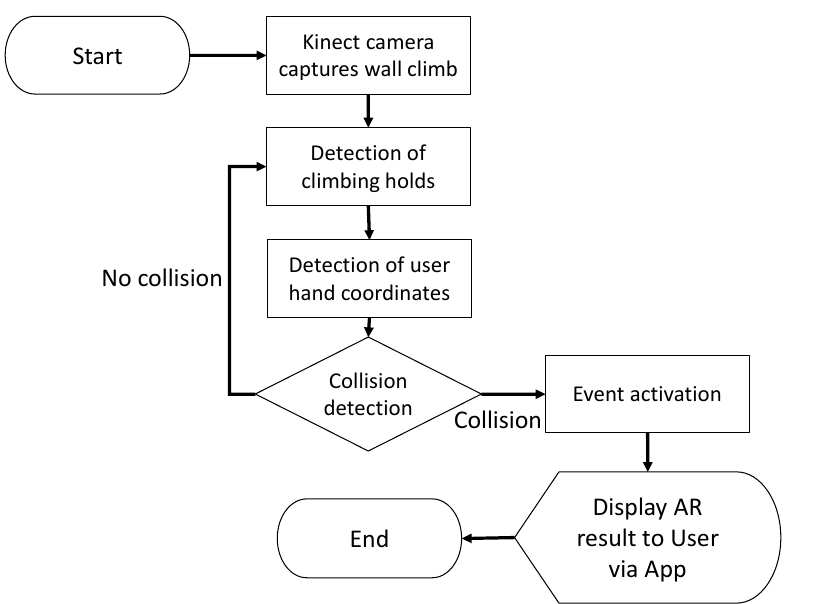
Figure 20. Flowchart for the Climbing Gym system.